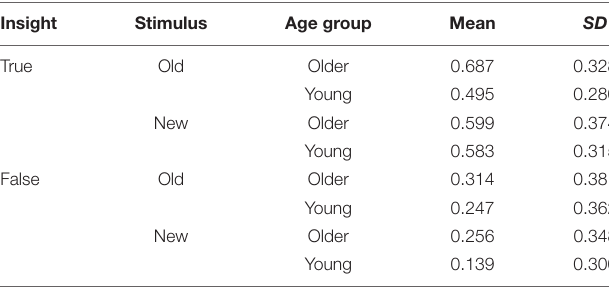
TABLE 9 | Proportion of reported Aha! Experiences.